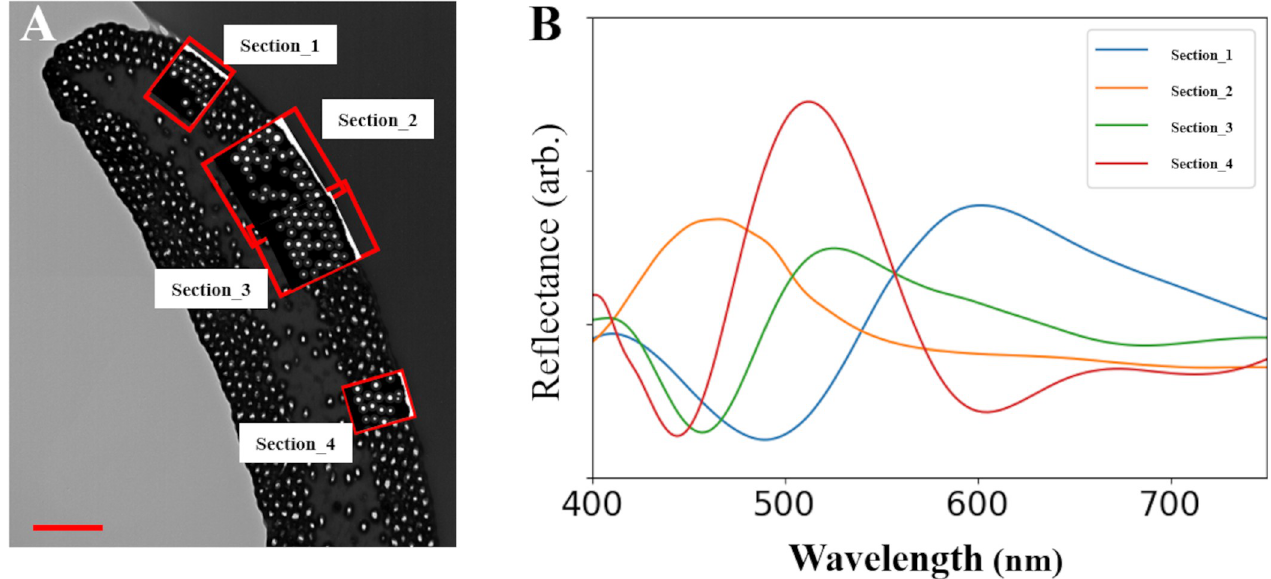
Fig 4. Reflectance spectra obtained from FDTD simulations. A Four simulated sections of the barbule, each with a height of around 1 μ m, corresponding to the size of the color domain. Enlarged images are presented in S3 Fig. B Spectra for the sections of the barbule calculated from the FDTD simulations. Each section has different peaks. Bar (A): 1 μ